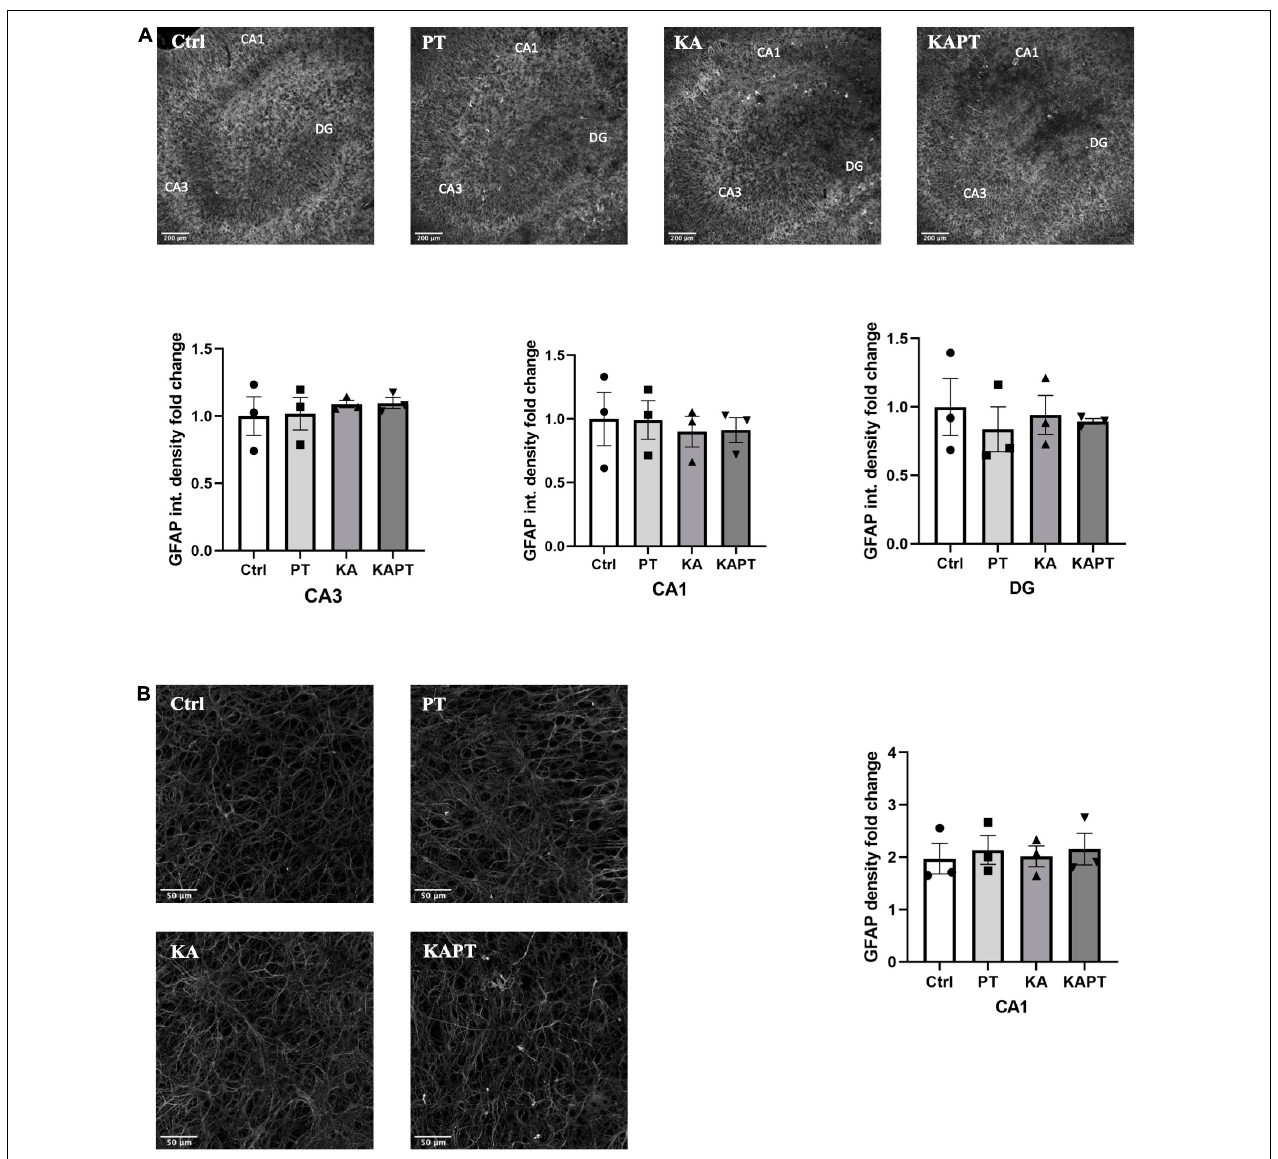
FIGURE 5 | Platinum nanoparticles (PtNPs) do not cause astrogliosis in organotypic hippocampal slices after 24 h of contact. (A) Representative GFAP immunostaining of organotypic hippocampal slices under control condition, PtNPs, kainic acid (KA) treatment, and KA treatment with PtNPs. Bottom charts represent the quantitative analysis of GFAP fluorescence intensity in CA3, CA1, and dentate gyrus (DG). (B) Magnified images of GFAP stained astrocytes at the level of the CA1 region. Right chart represents GFAP density quantification at the CA1 region showing non-significant differences in all the treatment groups. Data are expressed as integrated density and density fold change from the value of control slices and presented as means ± standard error of the mean (SEM) ( n = 3 independent experiments; 4–6 slices analyzed per group/experiment). Tukey’s test after one–way analysis of variance (ANOVA) was used for statistical